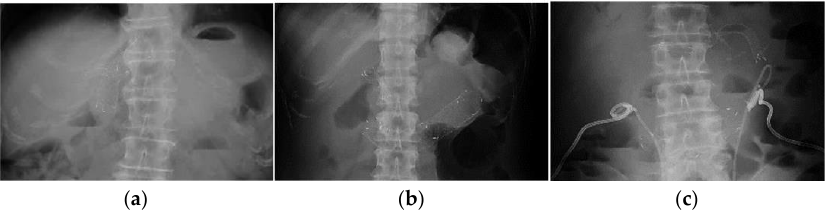
Figure 3. X-ray images of type 2 obstruction in the SEMS cohort ( n = 3). ( a ) Endoscopic biliary self- expandable metal stent placement had already been performed before the placement of a self-ex- pandable metal stent for malignant afferent loop obstruction. ( b ) Simultaneous endoscopic biliary and duodenal self-expandable metal stent placement. ( c ) Endoscopic ultrasound-guided hepati- cogastrostomy was performed a few days after duodenal self-expandable metal stent